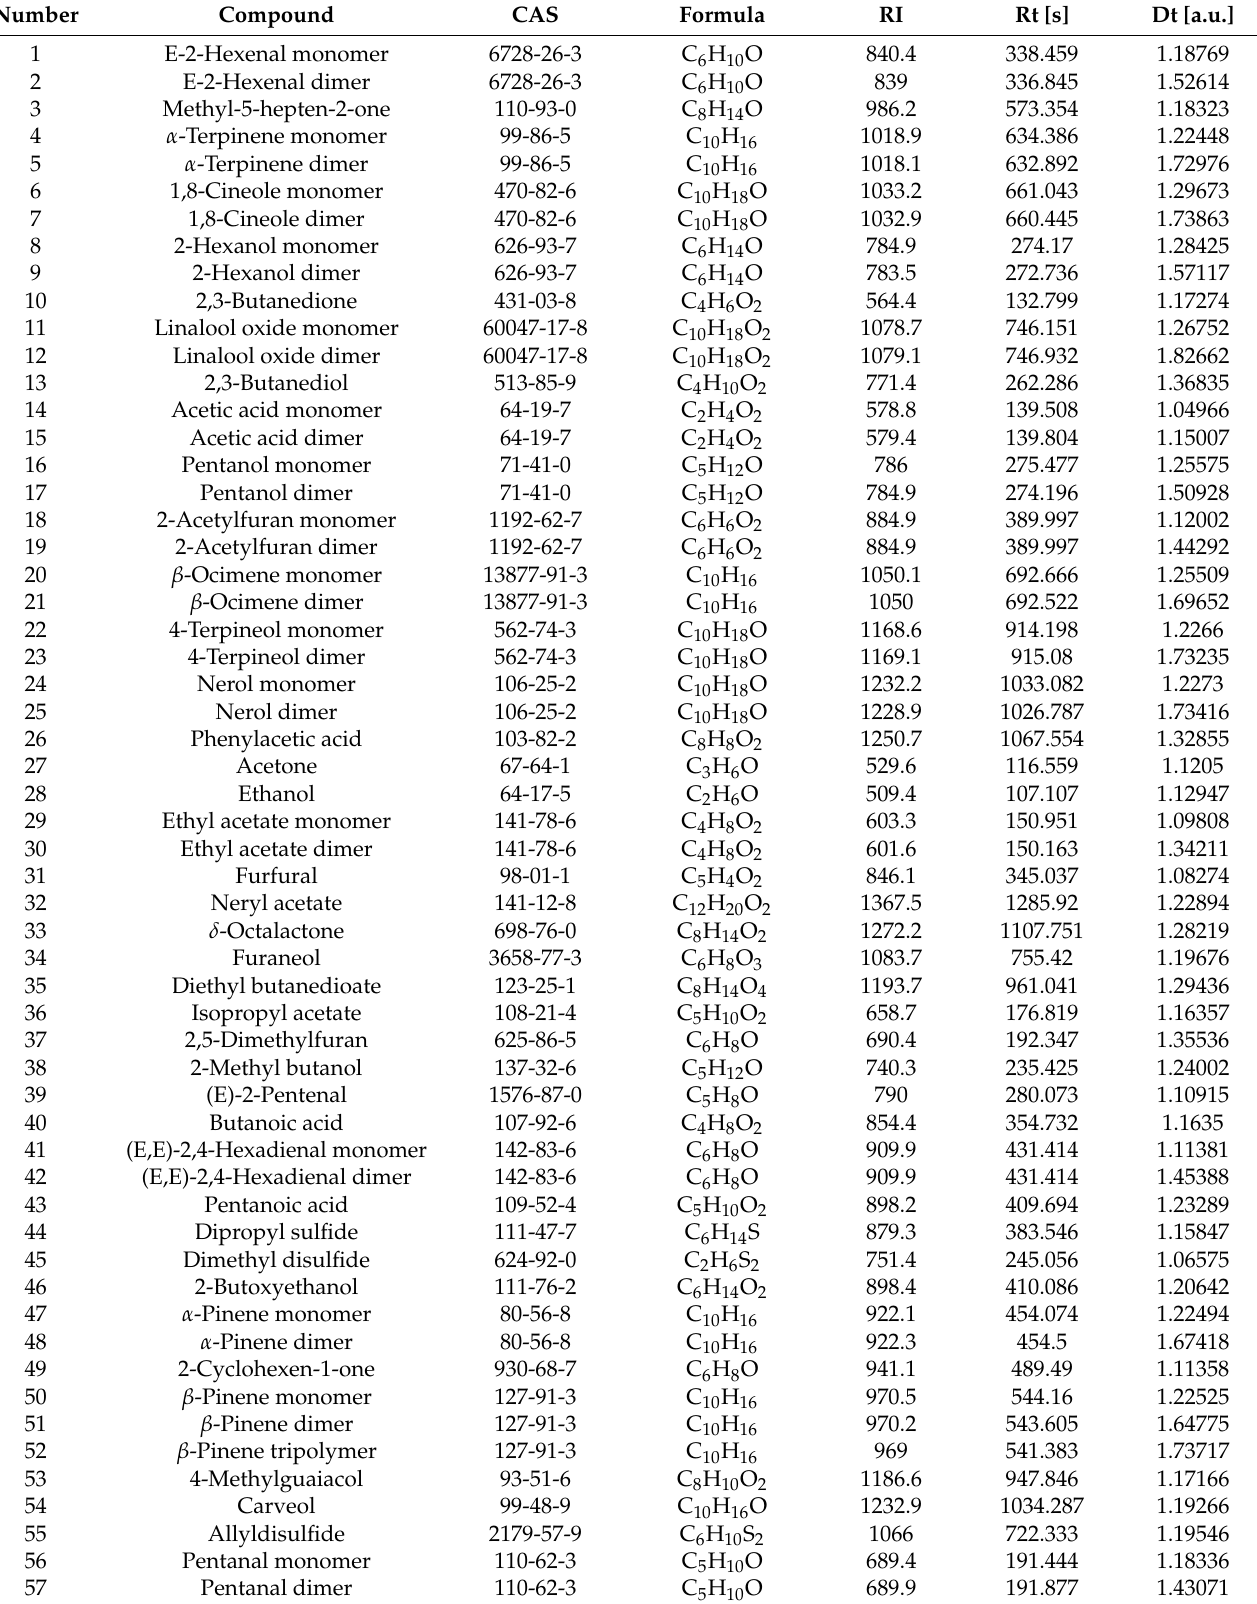
Table 1. HS-GC-IMS integration parameters of VOCs in SHJ, SJ, SHJY, and